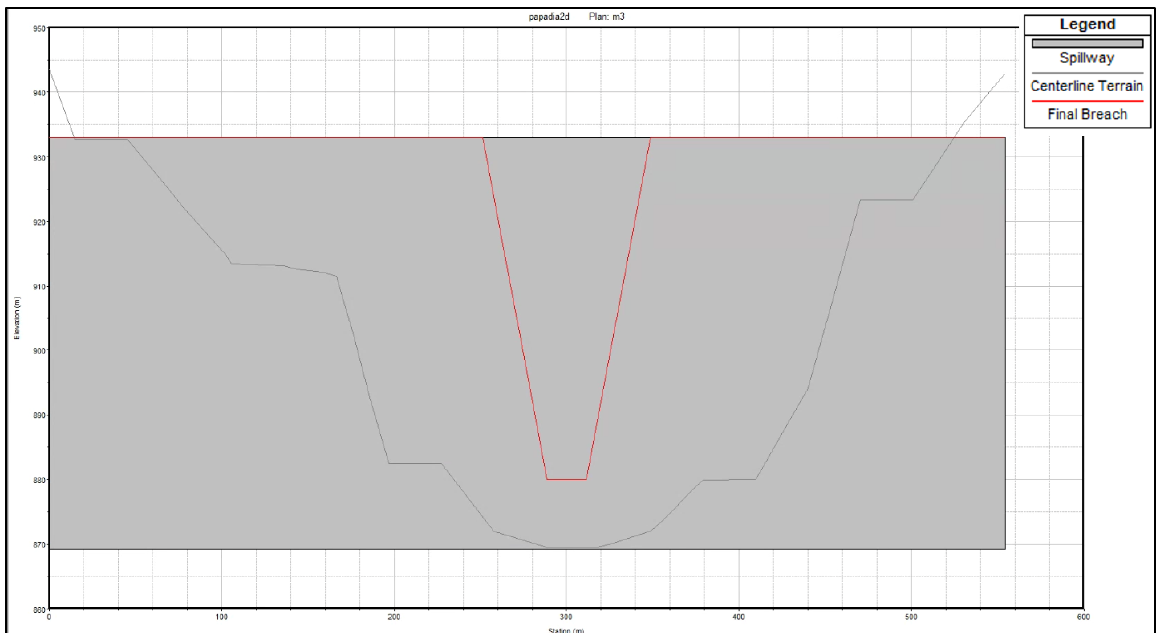
Figure 6. Final dam breach geometry plot (overtopping).